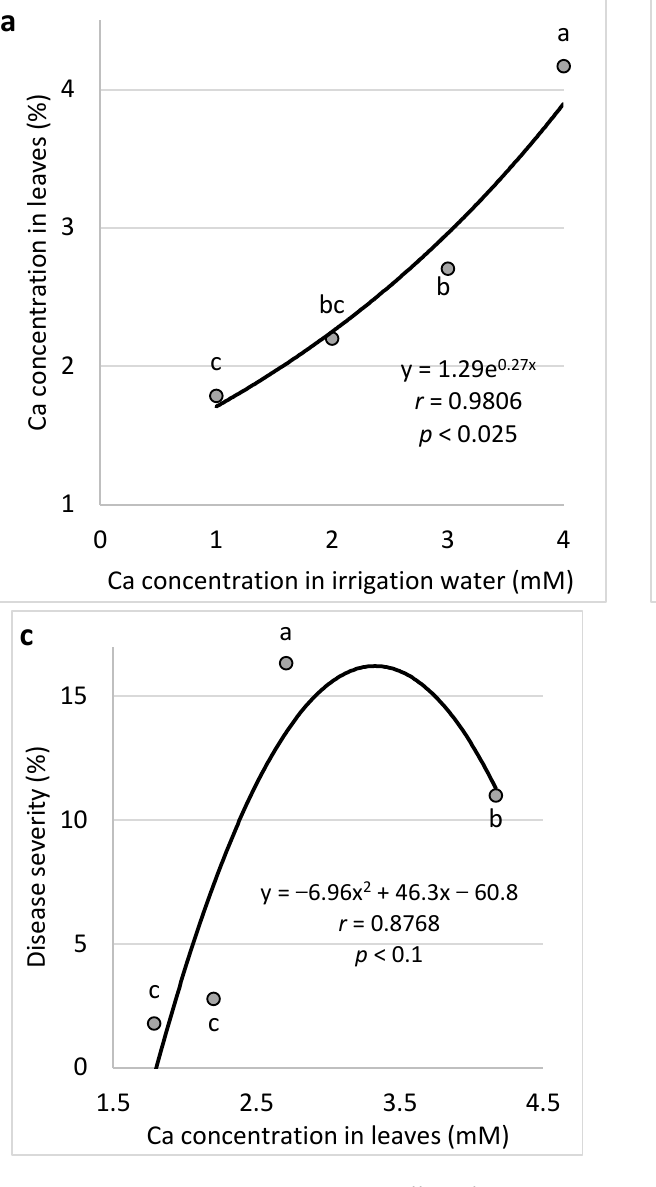
Figure 4. Effect of Ca concentration treatments in the irrigation water on cucumber downy mildew (CDM, Pseudoperonospora cubensis ). Ca concentration in the leaves is presented in relation to Ca concentration in the irrigation water ( a ), CDM severity is presented in relation to Ca concentration in the irrigation water ( b ), and CDM severity is presented in relation to the Ca concentration in the leaves ( c ). The disease was evaluated on a 0 to 100% severity scale, where 0% = healthy leaves and 100% = leaves completely covered by CDM symptoms. Values of the area under the disease progress curve (AUDPC) were calculated for 18 days after disease onset. In each graph, values for each Ca treatment followed by a common letter are significantly not different from each other according to Tukey-Kramer’s HSD test ( p ≤ 0.05). The regression formulas of the drawn trend lines are presented, and the correlation Pearson regression values ( r ) are presented along with significance levels ( p